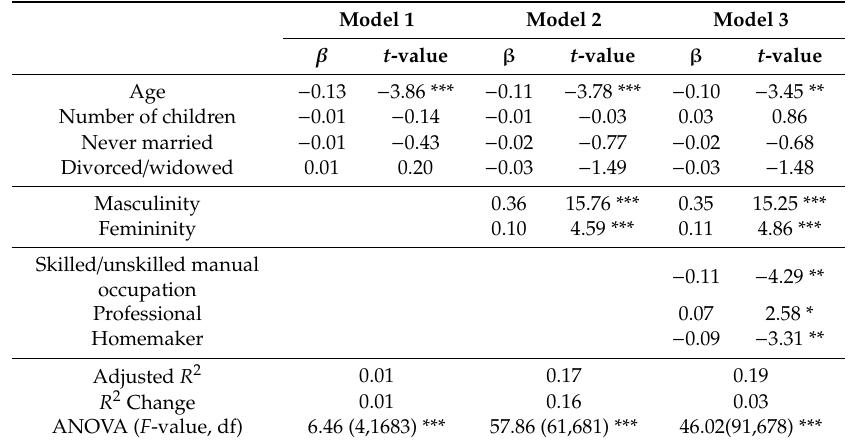
Table 4. Summary of the hierarchical regression with the psychological well-being factor as the dependent measure for the women’s group.